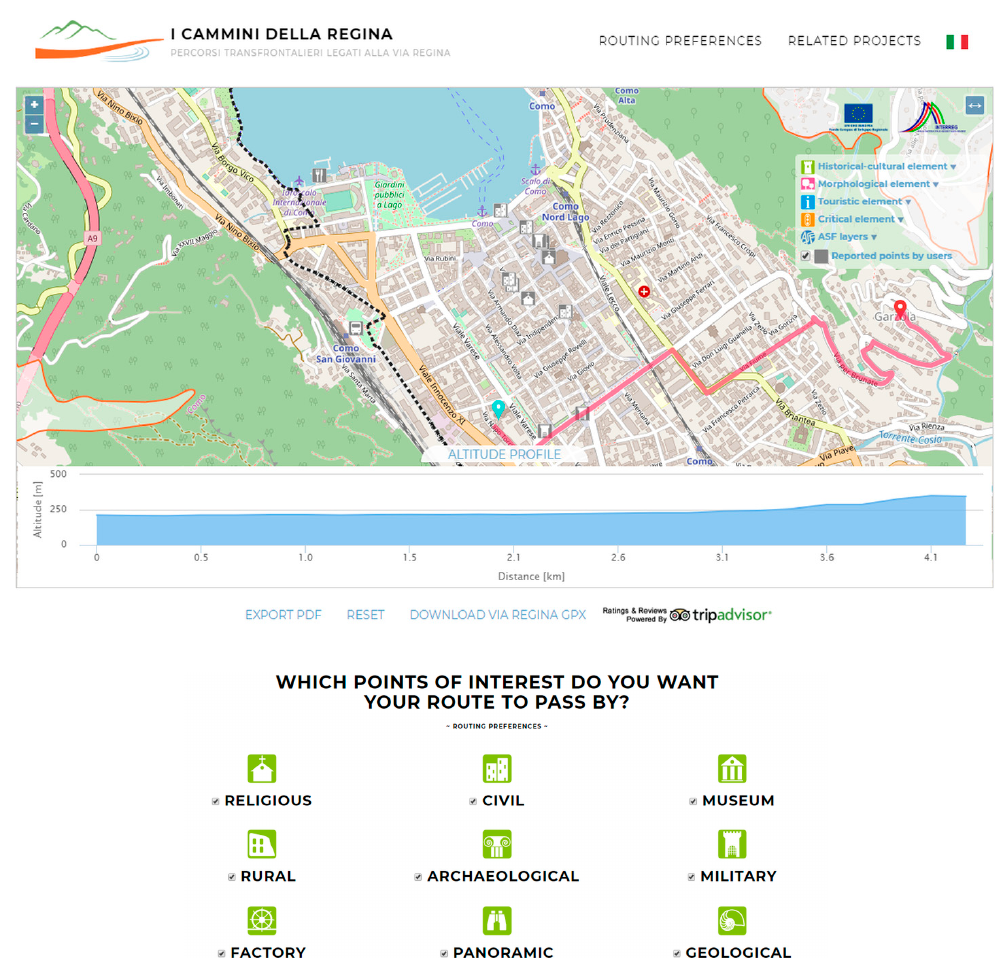
Figure 3. The Paths of the Queen (in Italian “I cammini della Regina”) geoportal: routing is based on the minimum distance and points of interest (http://viaregina3.como.polimi.it/ViaRegina/index-en.html, accessed on 19 October 2019). The geoportal helps tourists to plan their trip using the typology of the points of interest they want to visit. It promotes slow tourism, i.e., sustainable and respectful of the environment and territory.